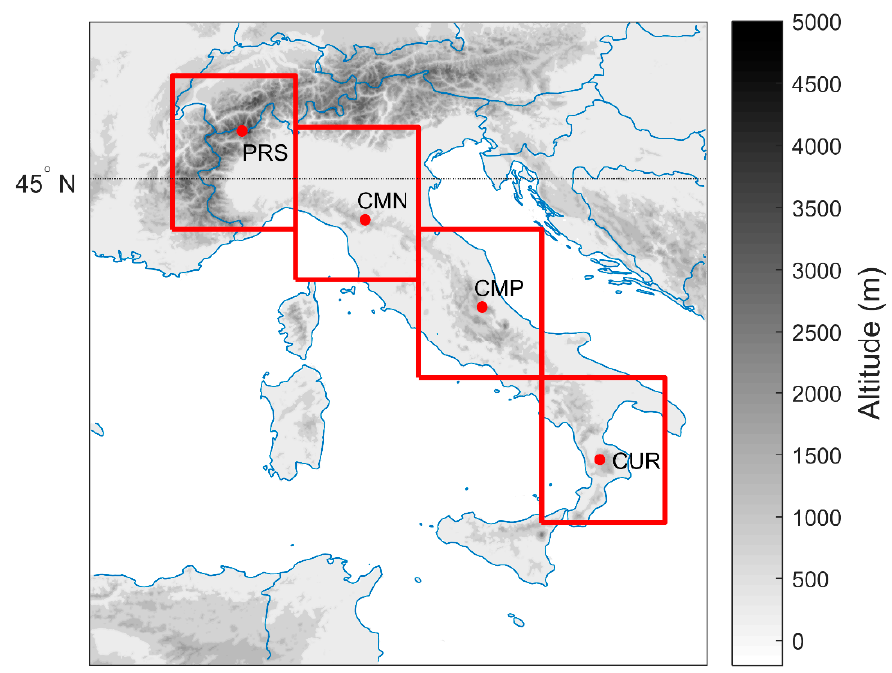
Figure 1. Geographic location of the measurement sites considered in this study. Abbreviations are as follows: PRS—Plateau Rosa, CMN—Mt. Cimone, CMP—Mt. Portella—Campo Imperatore, and CUR—Mt. Curcio. The boxes denote the 3° × 3° horizontal extension of the STEFLUX box around each measurement site.